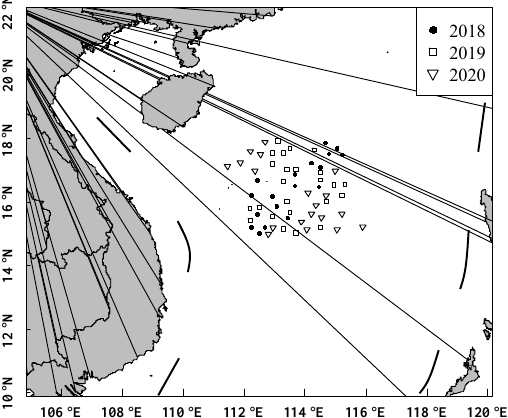
Figure 1. Site of investigations and sample collection for S . oualaniensis .